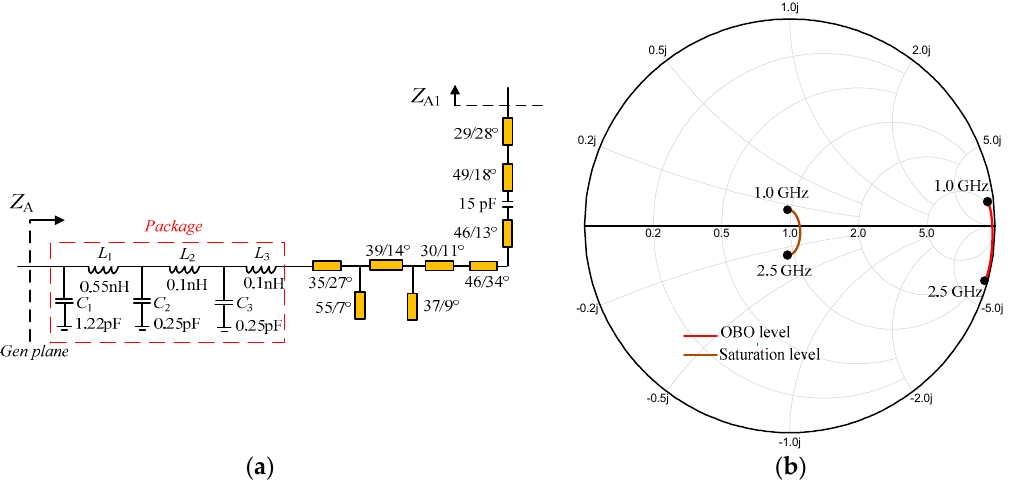
Figure 11. Auxiliary PA branch: ( a ) designed output network; ( b ) simulated Z A .